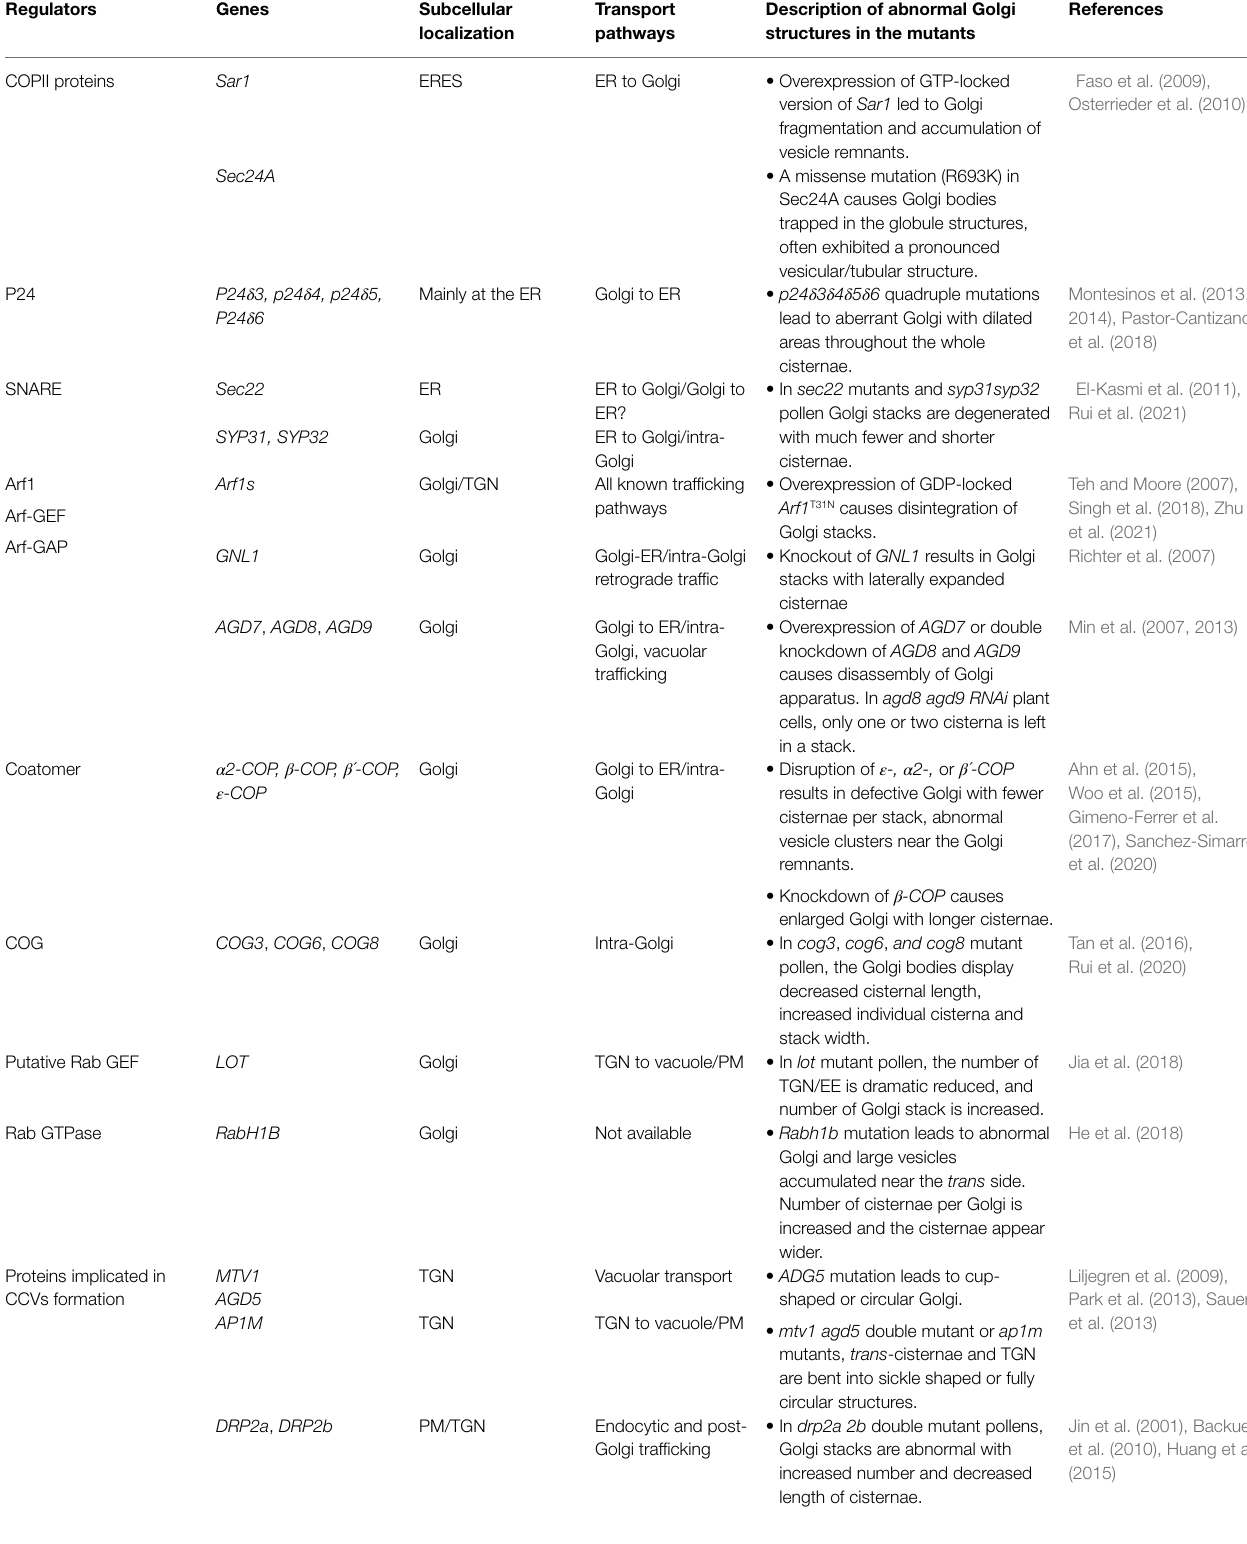
TABLE 1 | Key genetic elements involved in plant Golgi structure maintenance.